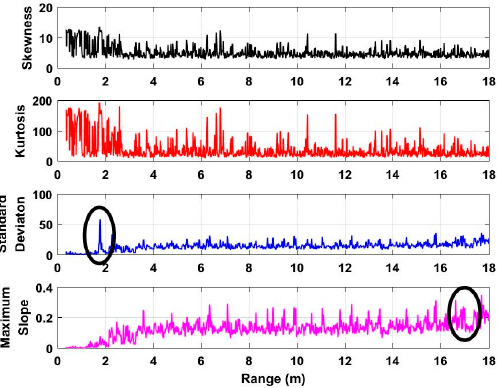
Figure 7. The analyzed characteristics based on the data without human beings in the experiment.